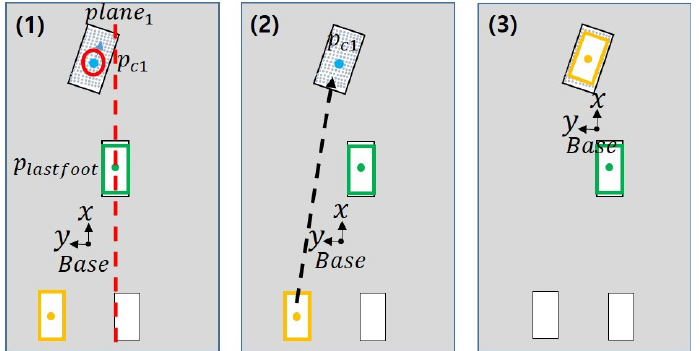
Figure 9. Results when the last swing foot and the swing foot calculated in (1) are different. ( 1 – 3 ) are the process of selecting footstep and